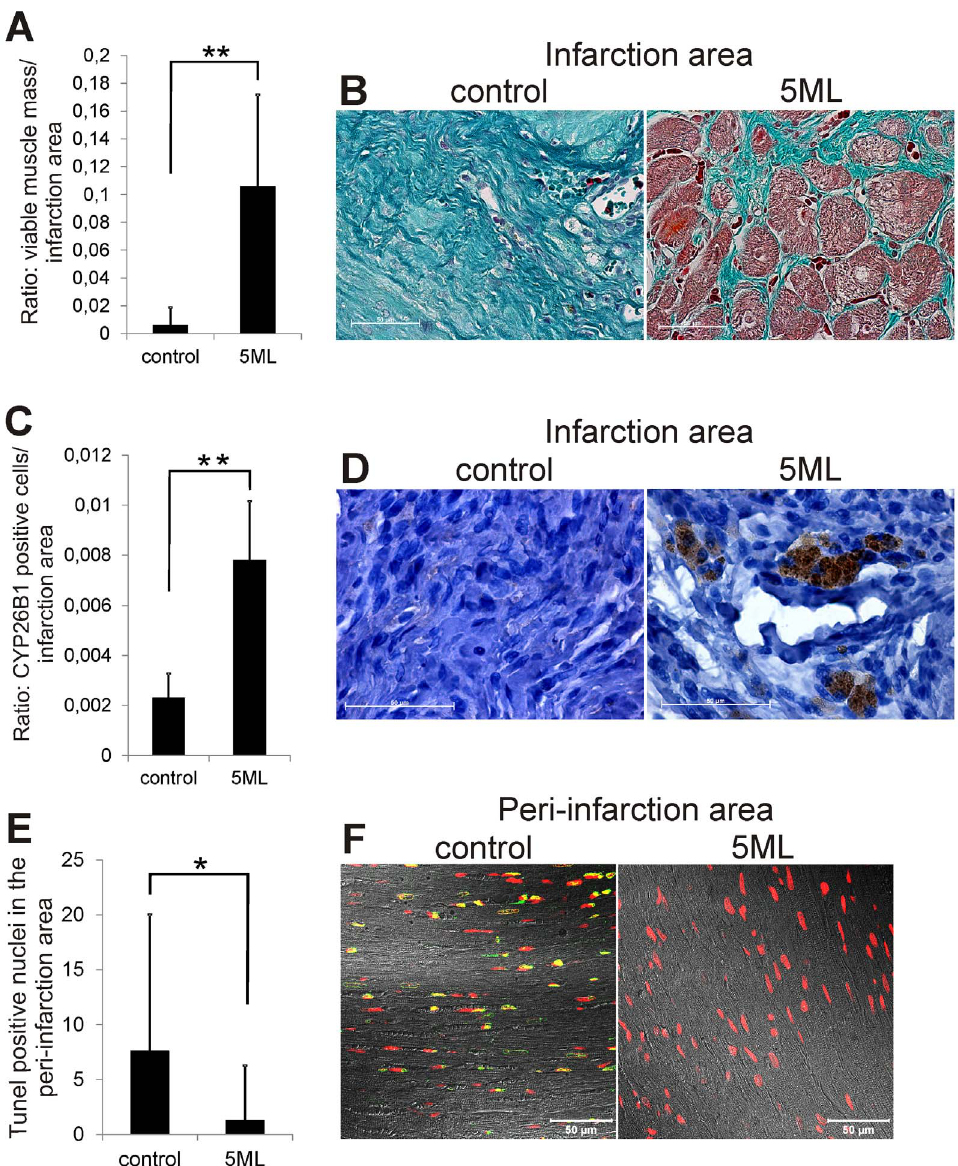
Figure 5. 5ML treatment increase the amount of viable cardiac tissue, increases the CYP26B1 expression in the infarction area, and reduces the number of Tunel positive cells in the peri-infarction area. Figure 5A shows the quantification of the viable cardiac tissue within the highly fibrotic infarction area (n=7 per group). Figure 5B shows the staining of heart sections with Masson’s Trichrome that visualizes the viable heart muscle (red staining) and the fibrotic area (intensive blue staining) (magnification 63 6 ). Quantitative image analysis (of all images, n=7 per group) of the CYP26B1 expression in the infarction area is depicted in Figure 5C. Figure 5D shows representative images of CYP26B1- immunohistochemically stained heart sections of control and 5ML treated rat hearts (magnification 100 6 ). Quantification of the number of Tunel positive nuclei in the peri-infarction area is shown in Figure 5E (n=7 per group). Figure 5F shows representative images of Tunel-stained cardiomyocytes in the per-infarction area of control and 5ML treated rat hearts (magnification 40 6 ). Asterisks indicate significant differences (* p , 0.05; ** p , 0.01) compared to the corresponding control group. limited to the infarction area. Analysis of DNA-strand breaks as the result of apoptotic signaling in cardiomyocytes (verified by the overlay of fluorescence images with transmitted light images of the peri-infarction area) indicated that 5ML significantly reduced the number of TUNEL positive cells also in the peri-infarction area (Figure 5E and Figure 5F).